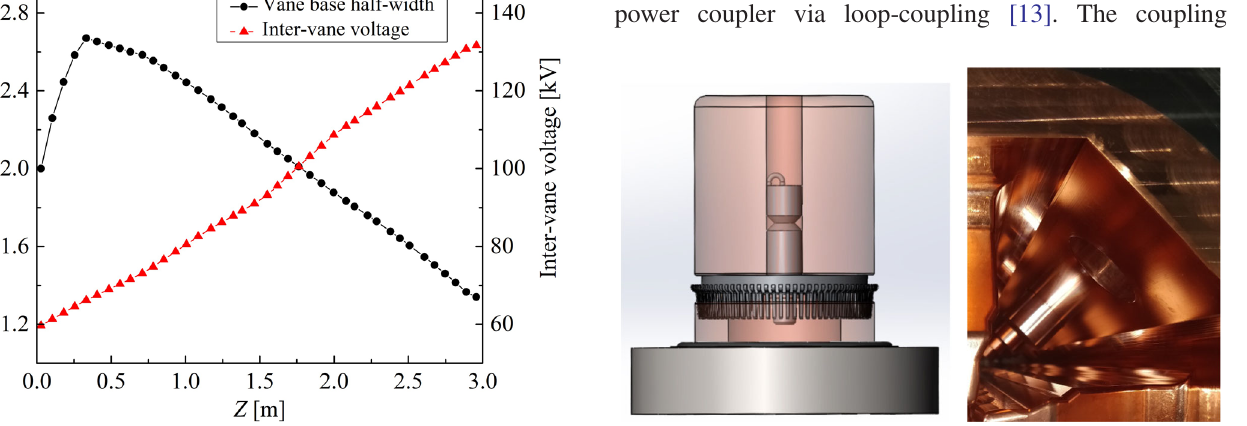
FIG. 7. Structure drawings of one tuner with one probe inside (left) and tuners inside the RFQ cavity